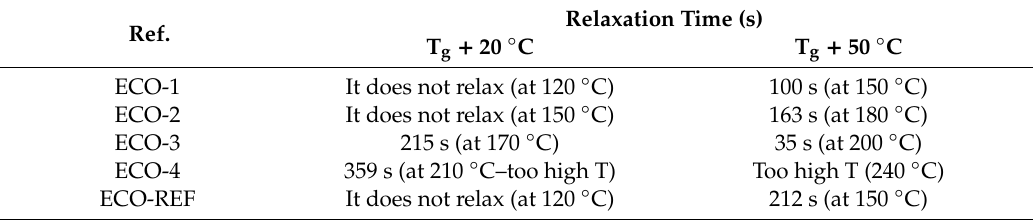
Table 3. Relaxation times at di ff erent temperatures ((T g + 20 ◦ C) and (T g + 50 ◦ C)) for the